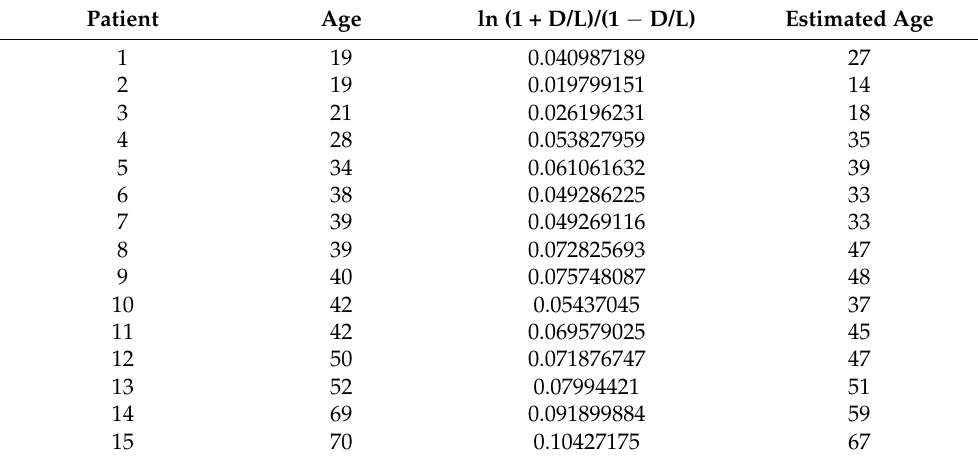
Table 2. Aspartic acid racemization rates with respect to the chronological age in a Spanish sample; training set. Age was estimated based on these racemization rates and the regression formula. In black, teeth from Asturias population; in red, teeth from Catalonia population.